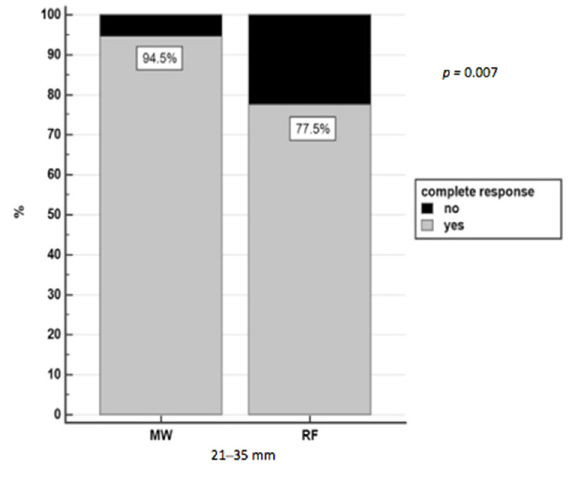
Figure 2. Complete response in nodules 15–35 mm treated with RFA and MWA.